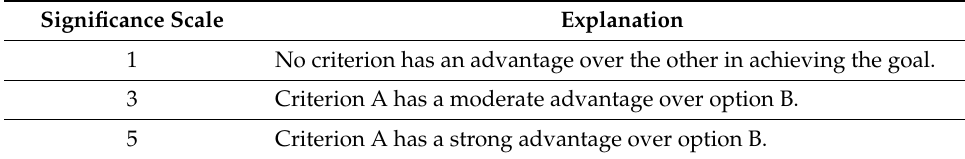
Table 1. Saaty’s scale used to compare criteria in pairs (own study based on [52]). Significance Scale Significance